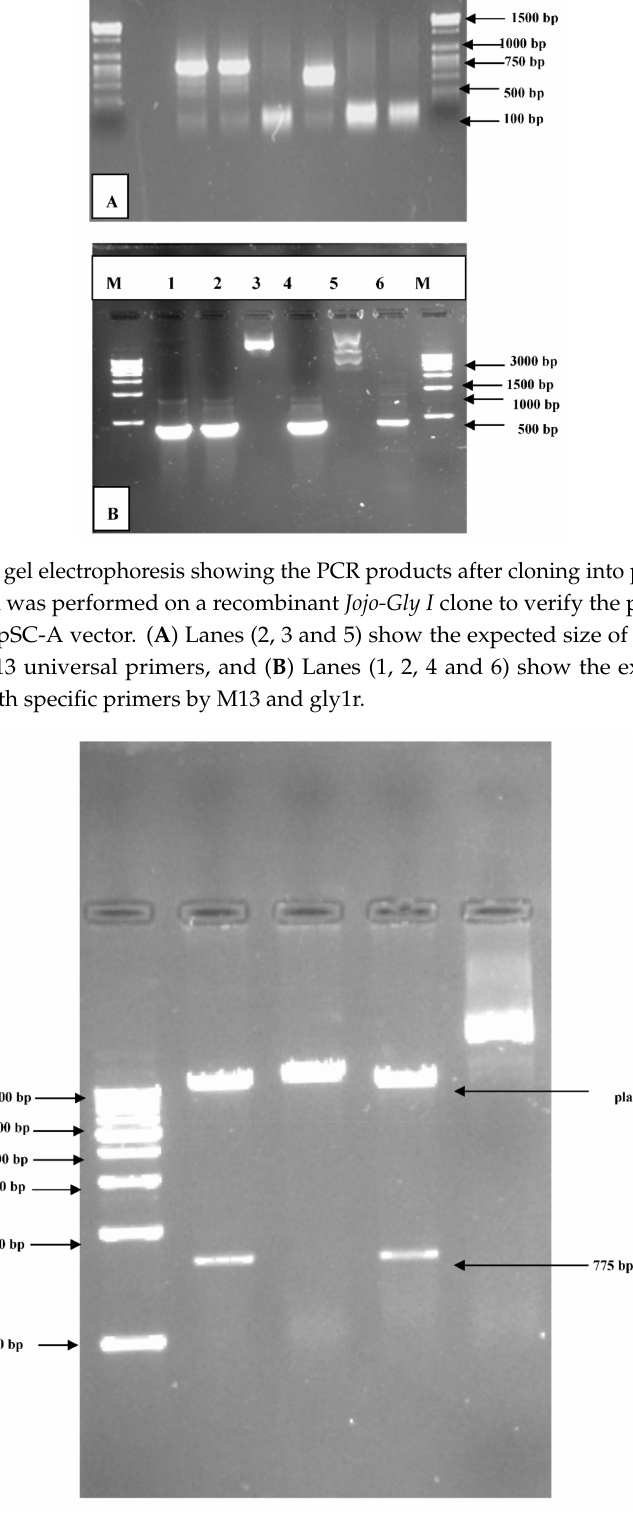
Figure 9. Restriction digestion products for the clone of Jojo-Gly I after cloning the Jojo-Gly I in pSC-A vector and digestion by Xba I and BamH